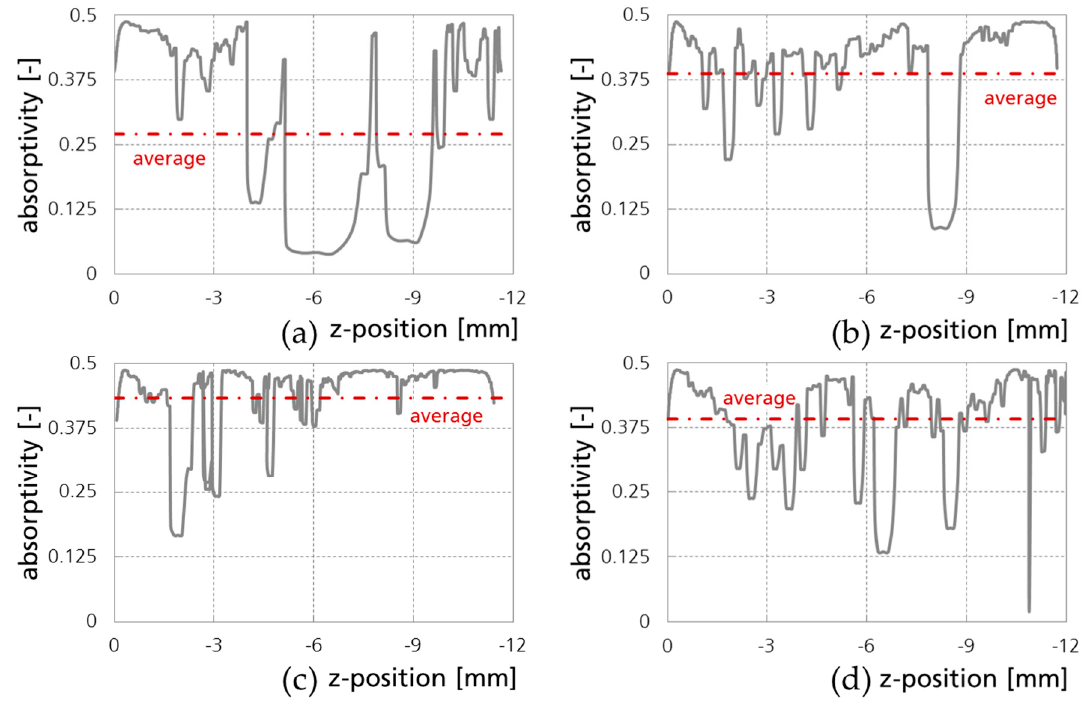
Figure 12. Local absorptivity along the cut front of 12 mm stainless steel cut with the following parameters: ( a ) Set #1: Static beam shaping; and different values of the longitudinal, linear beam oscillation parameters; ( b ) Set #2: 300 µ m amplitude and 500 Hz frequency; ( c ) Set #3: 550 µ m amplitude and 500 Hz frequency; ( d ) Set #4: 300 µ m amplitude and 2000 Hz frequency.